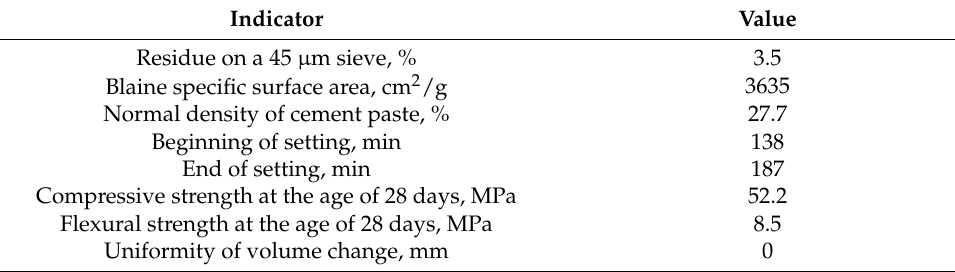
Table 1. Physical and mechanical characteristics of Portland cement.